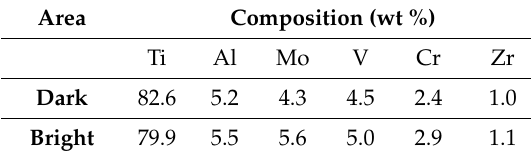
Figure 1. ( a ) Scanning electron microscopy image of the water ‐ quenched microstructure and ( b ) High ‐ Angle Annular Dark ‐ Field (HAADF) STEM image of the initial microstructure showing evidence of spinodal decomposition, given by the contrast between bright and dark areas and ( c ) electron diffraction pattern of the (113) β zone axis showing spots of athermal ω . Table 2. Results of EDS analyses in Figure 1 for the initial water-quenched condition of Ti-55531